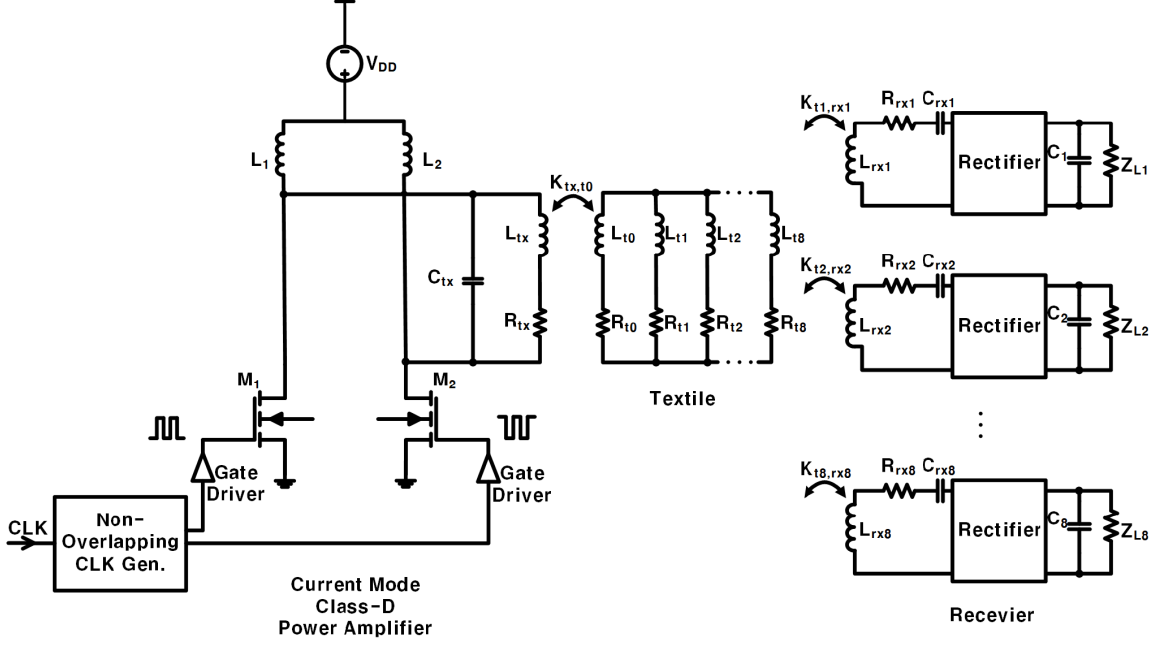
Figure 6. The designed circuit uses the CMCD.